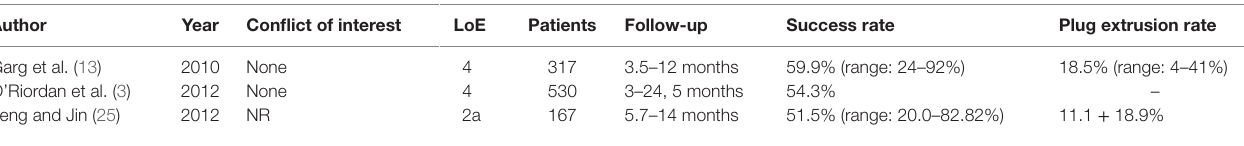
TABLe 1 | Results of systematic reviews about the efficacy of anal fistula plug in